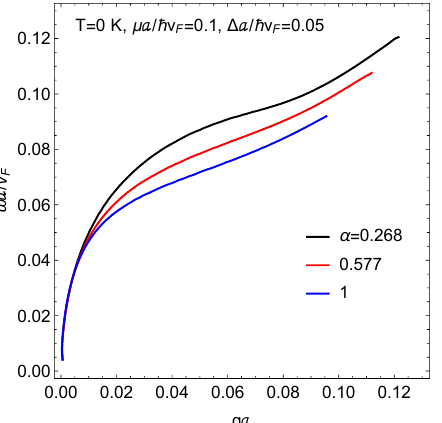
Figure 3. Plasmon dispersion as a function of the wave number for three values of the hopping parameter α and fixed mass parameter ∆ . The Fermi energy is within the conduction band.